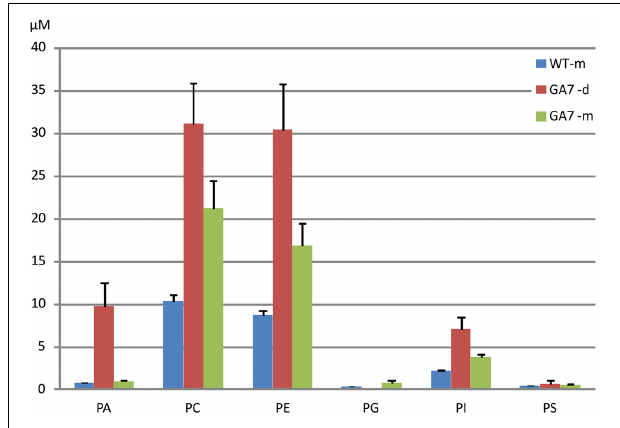
FIGURE 2 | Total phospholipids in developing and mature Arabidopsis seeds. Phosphatidic acid (PA), phosphatidylcholine (PC), phosphatidylethanolamine (PE), phosphatidylglycerol (PG), phosphatidylinositol (PI) and phosphatidylserine (PS) were determined from triplicate samples with the mean and standard deviation shown. WT-m, Columbia wild type mature seeds; GA7-d and GA7-m, developing and mature seeds of transgenic GA7 line containing a DHA biosynthetic pathway (genes are described in the text). Data are shown as the mean of triplicate analysis with the error bars representing the standard deviations, concentrations ( μ M) have been determined in the extracts from the same amount of dry seed weight for both developing and mature seeds.